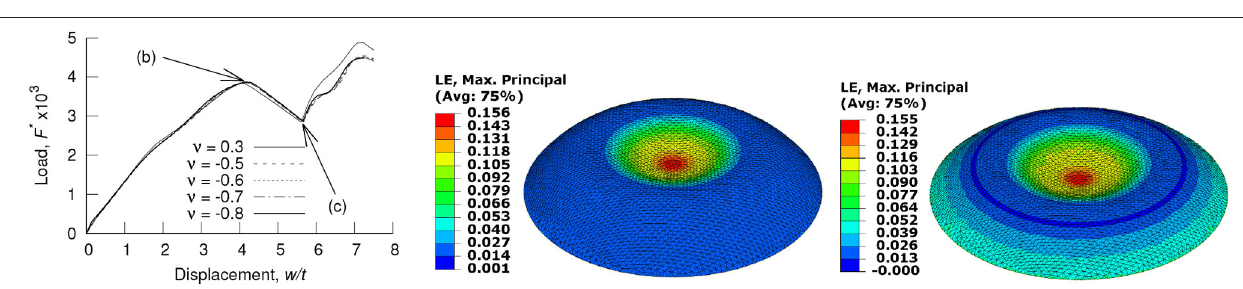
FIGURE 2 | FE snap-through response in the plate compression of a solid dome, showing: (Left) a snap through response, and the maximum principal logarithmic strain, ǫ 1 , at (Middle) buckling and (Right) after